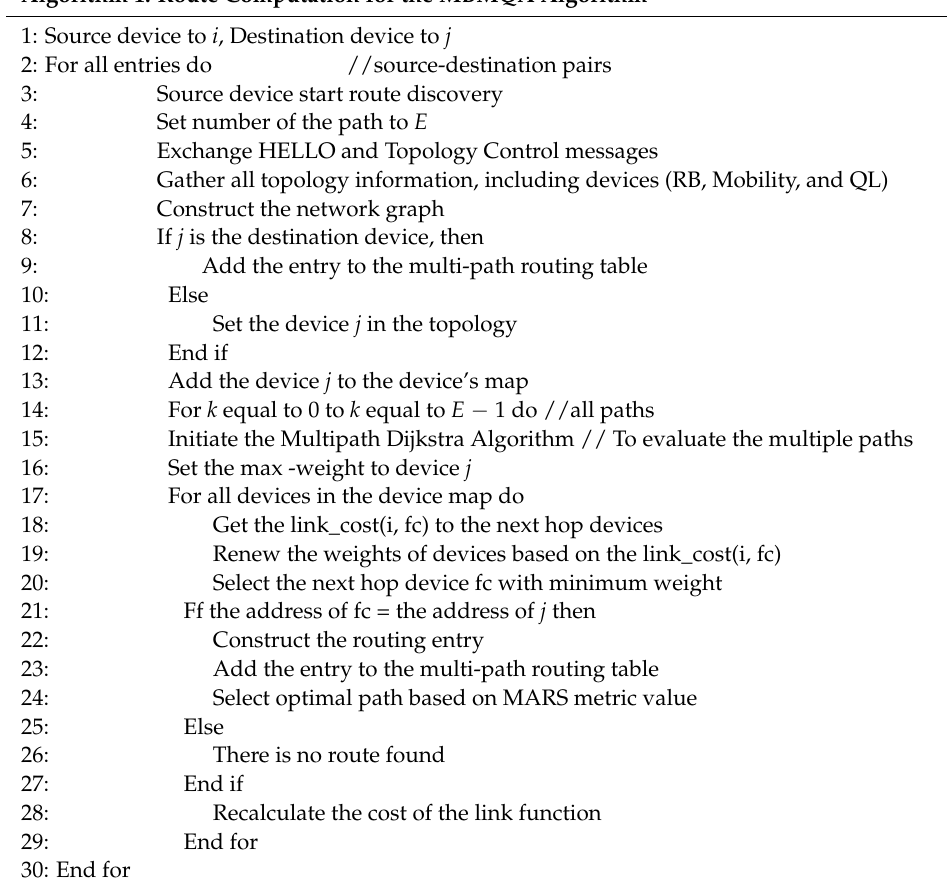
Algorithm 1. Route Computation for the MBMQA